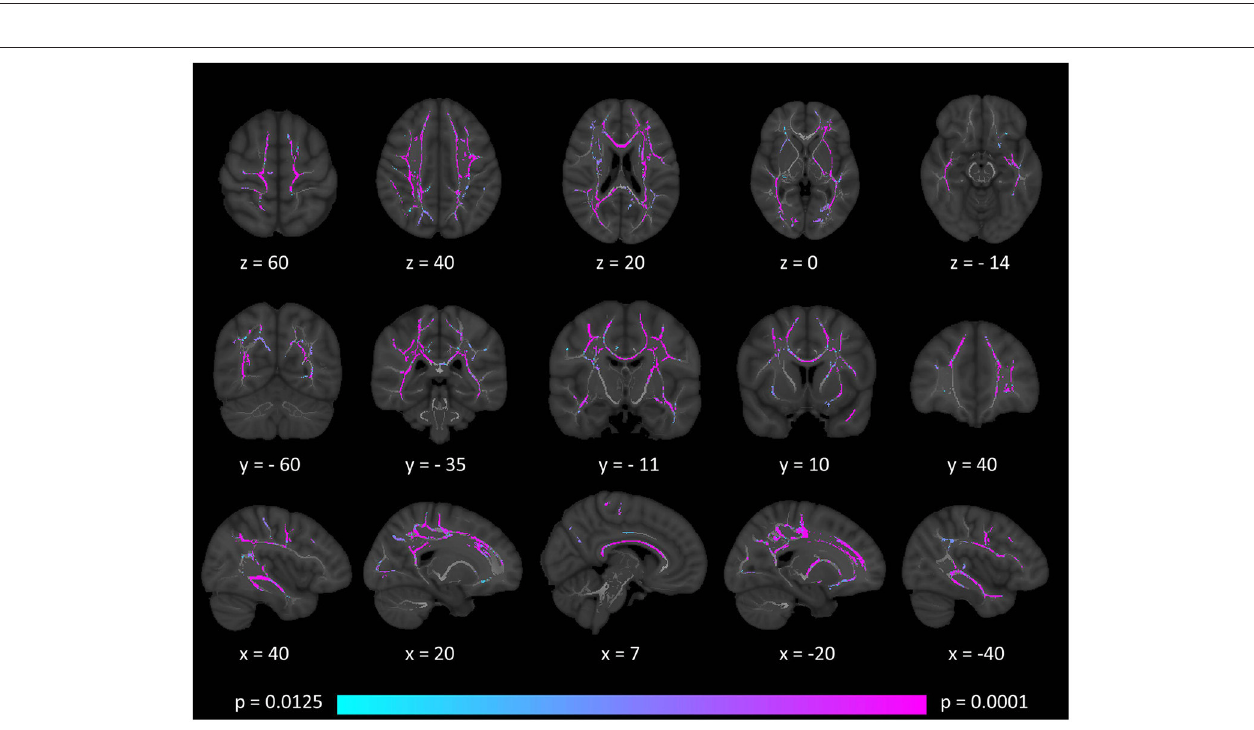
FIGURE 4 | Patterns of increased mean diffusivity (MD) in multiple sclerosis patients with gave-evoked nystagmus compared to healthy controls at p < 0.0125 FWE adjusted for age and gender following tract-based spatial statistics. Representative axial, coronal, and sagittal views are presented with corresponding MNI